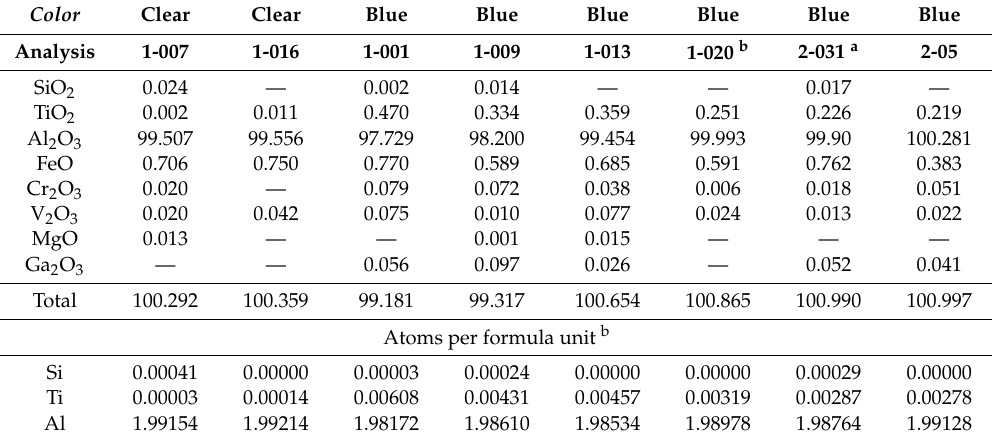
Table 1. Select corundum compositions from sample BD-35-93 a